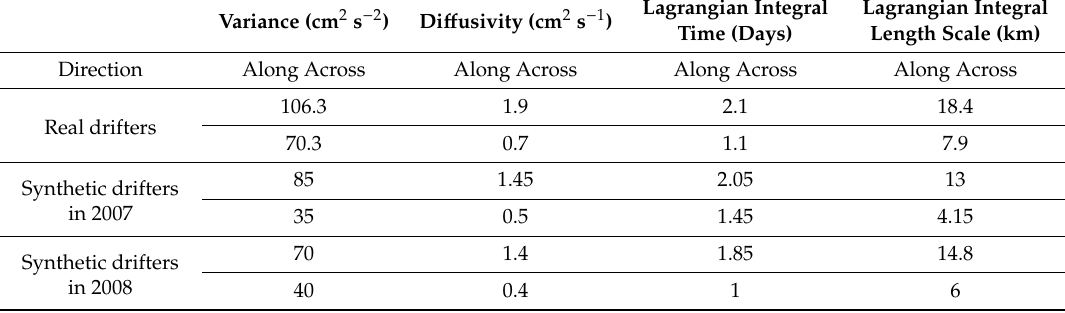
Figure 11. Lagrangian statistics (integral time scale) are shown versus time lags ranging between − 10 and 10 days for numerical particles in 2007 ( a ) and 2008 ( b ). Table 2. Lagrangian statistics for the whole Adriatic basin during 2007 and 2008 using synthetic trajectories compared with real drifter